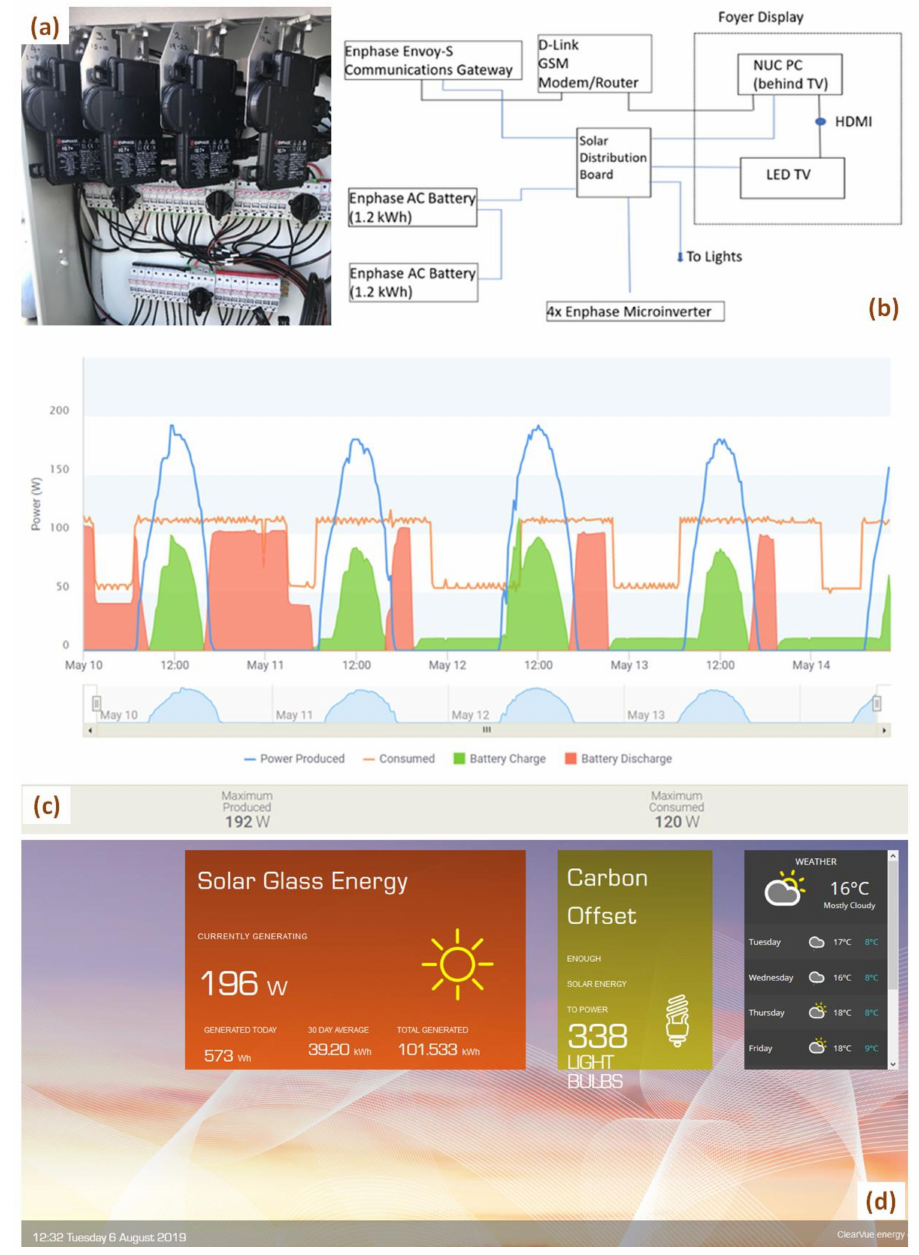
Figure 2. A graphical summary of the microgrid configuration details ( a , b ), sample data logs for the daily energy generation and use ( c ), and a photo of TV screen data showing a summary of system state ( d ), which is also available through live Internet broadcast at http: // tcp.iotstream.io / vicinity- warwickgrove / index.php with 15-minute data sampling